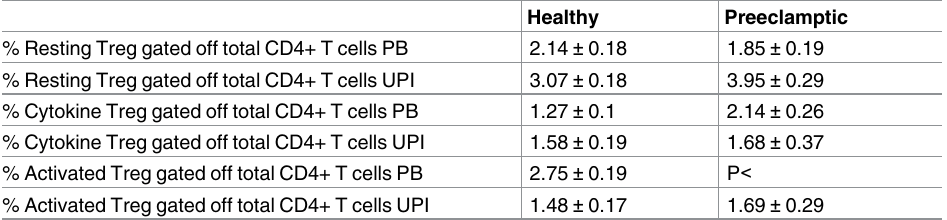
Table 10. Mean percentage +/- SEM Resting Treg, Cytokine Treg, and Activated T reg gated off total CD4+ T cells in PB and at the UPI of healthy and preeclamptic (PE) patients, see also Fig